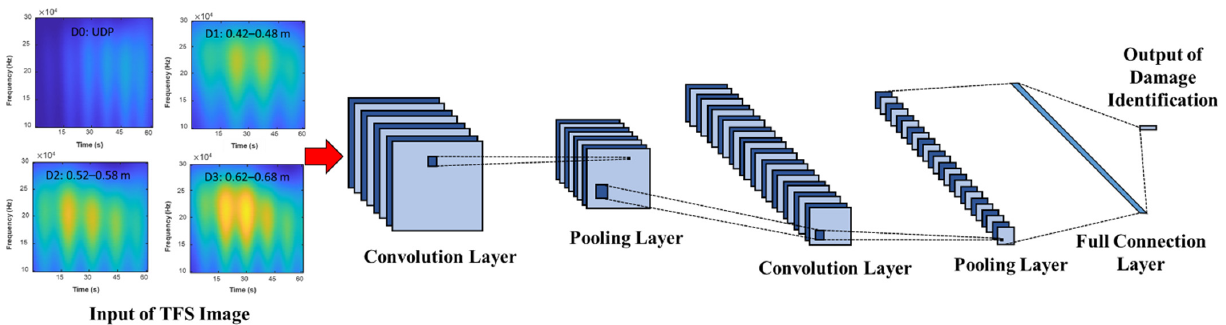
Figure 16. The architecture of a typical CNN.